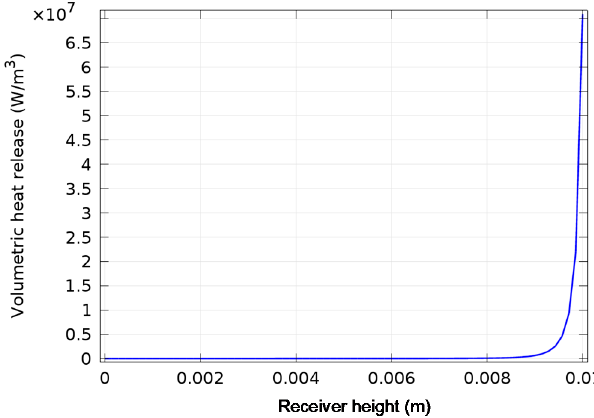
Figure 4. Volumetric heat release profile of receiver.